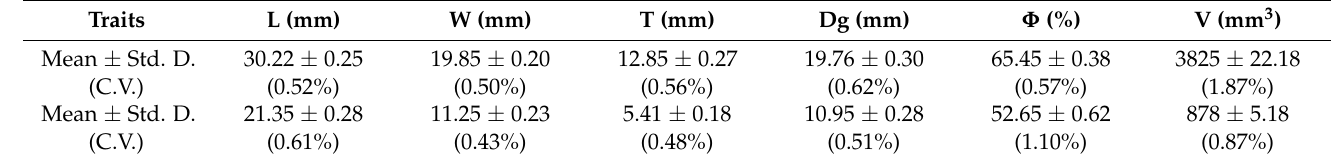
Table 1. Mean values of nut and kernel traits of almond cultivar ‘Tuono’.